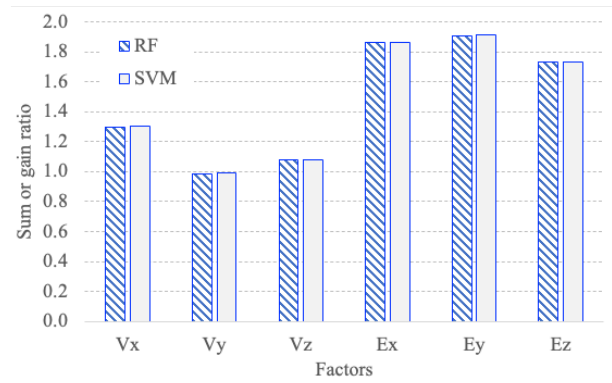
Figure 8. The factor ranking based on the gain